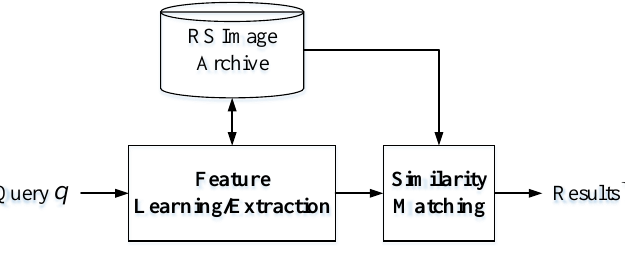
Figure 1. Basic flowchart of the remote sensing image retrieval method.